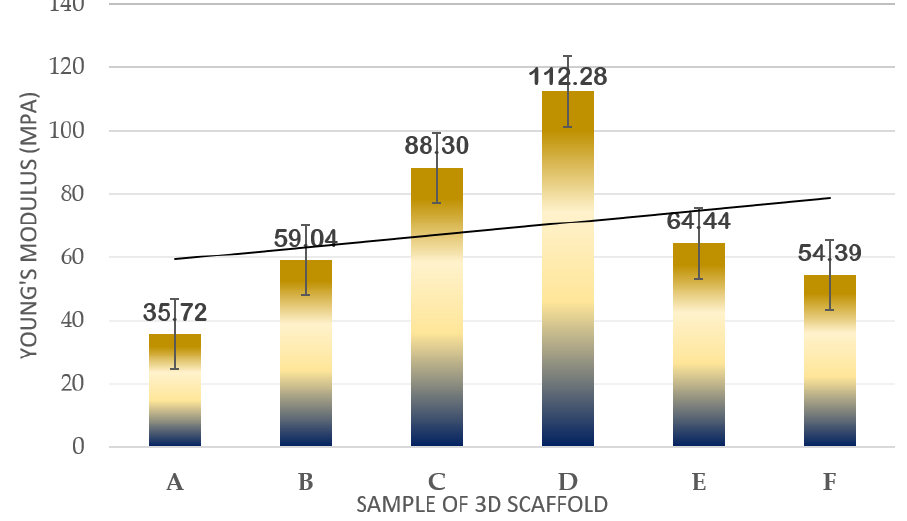
Figure 6. Plot of mechanical strength results in terms of Young’s Modulus of Figure 6. Plot of m echanical strength results in terms of Young’ s Modulus of samples. Table 1. Young’s Modulus of scaffold s at different concentrations with and without ϒ -Fe 2 O 3.